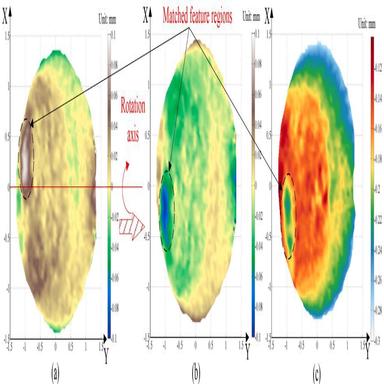
Realignment of contact pair geometries. (a) Original stationary electrode geometry. (b) Rotated stationary electrode geometry. (c) Original movable electrode geometry.